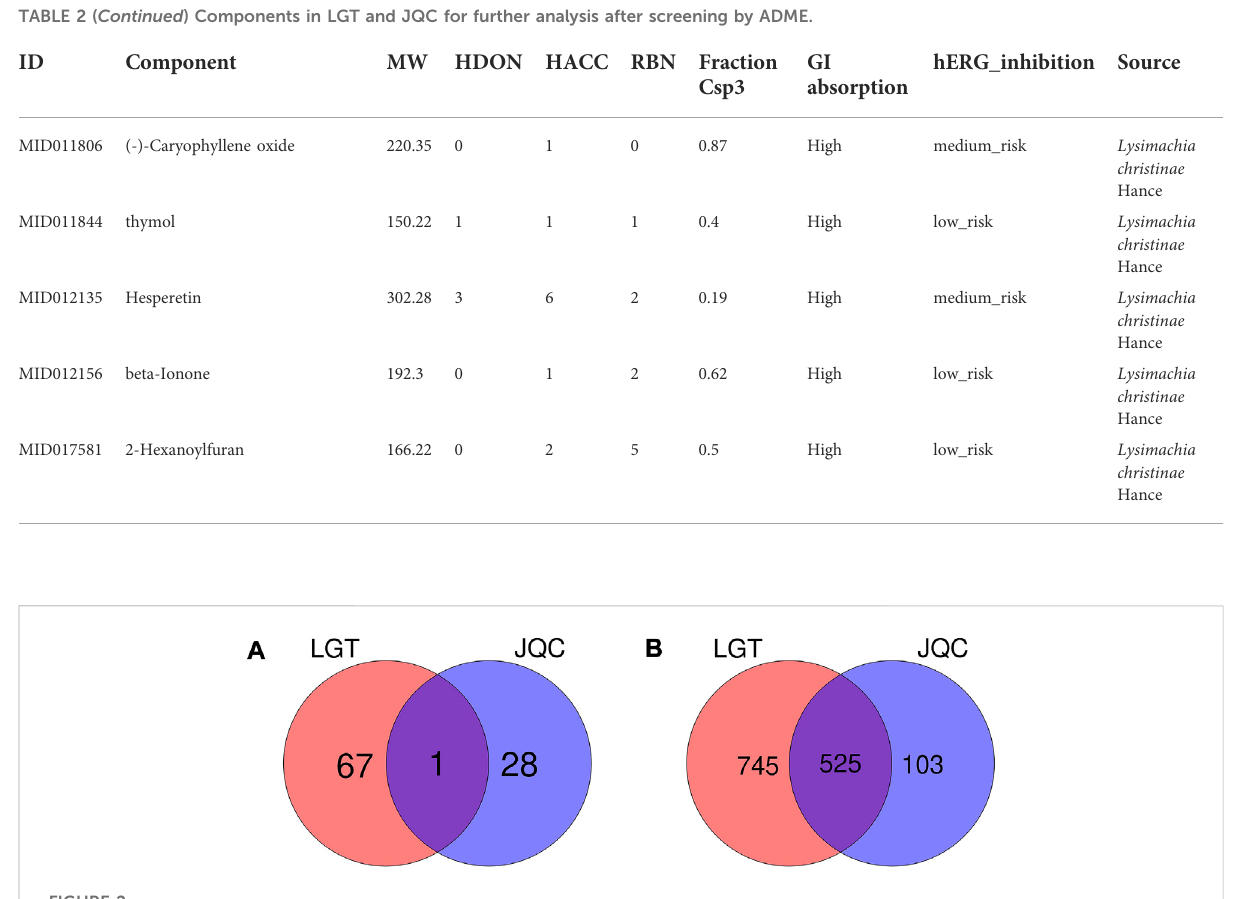
FIGURE 2 Venn diagram of components and targets of LGT and JQC. (A) Common and speci fi c components of LGT and JQC. (B) Common and speci fi c targets for LGT and